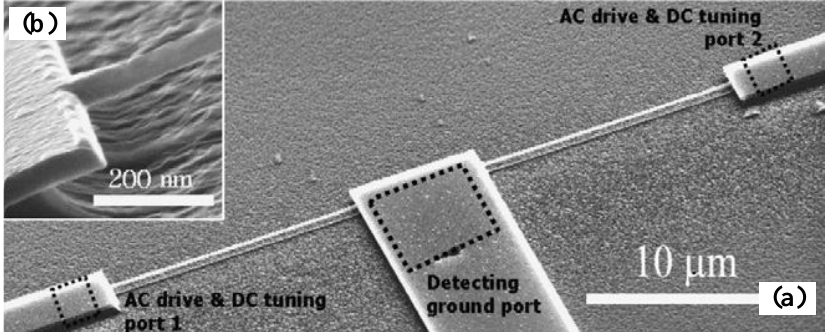
Figure 19. ( a ) SEM of a completed nano-mechanical resonator [16]. The nanobeams with two AC driving and DC tuning ports and a detection port; ( b ) Close-up view of